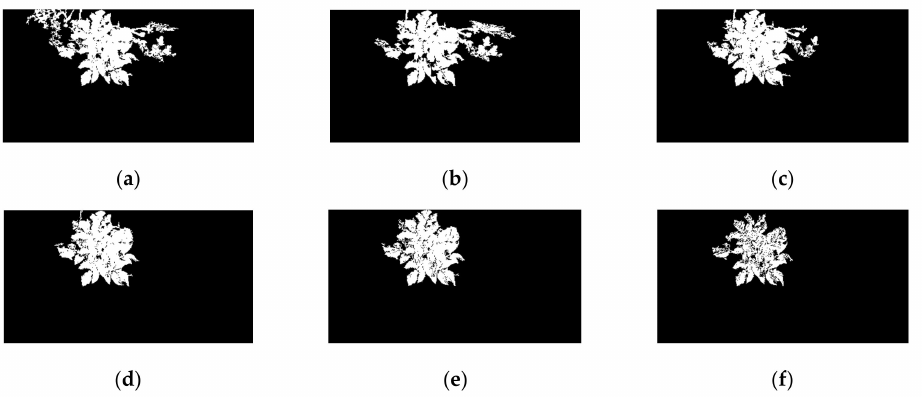
Figure 8. Precision segmentation result after MDVI–OTSU under six modified coe ffi cients. ( a ) α = 0.5; ( b ) α = 1.0; ( c ) α = 1.5; ( d ) α = 2.0; ( e ) α = 2.5; ( f ) α =